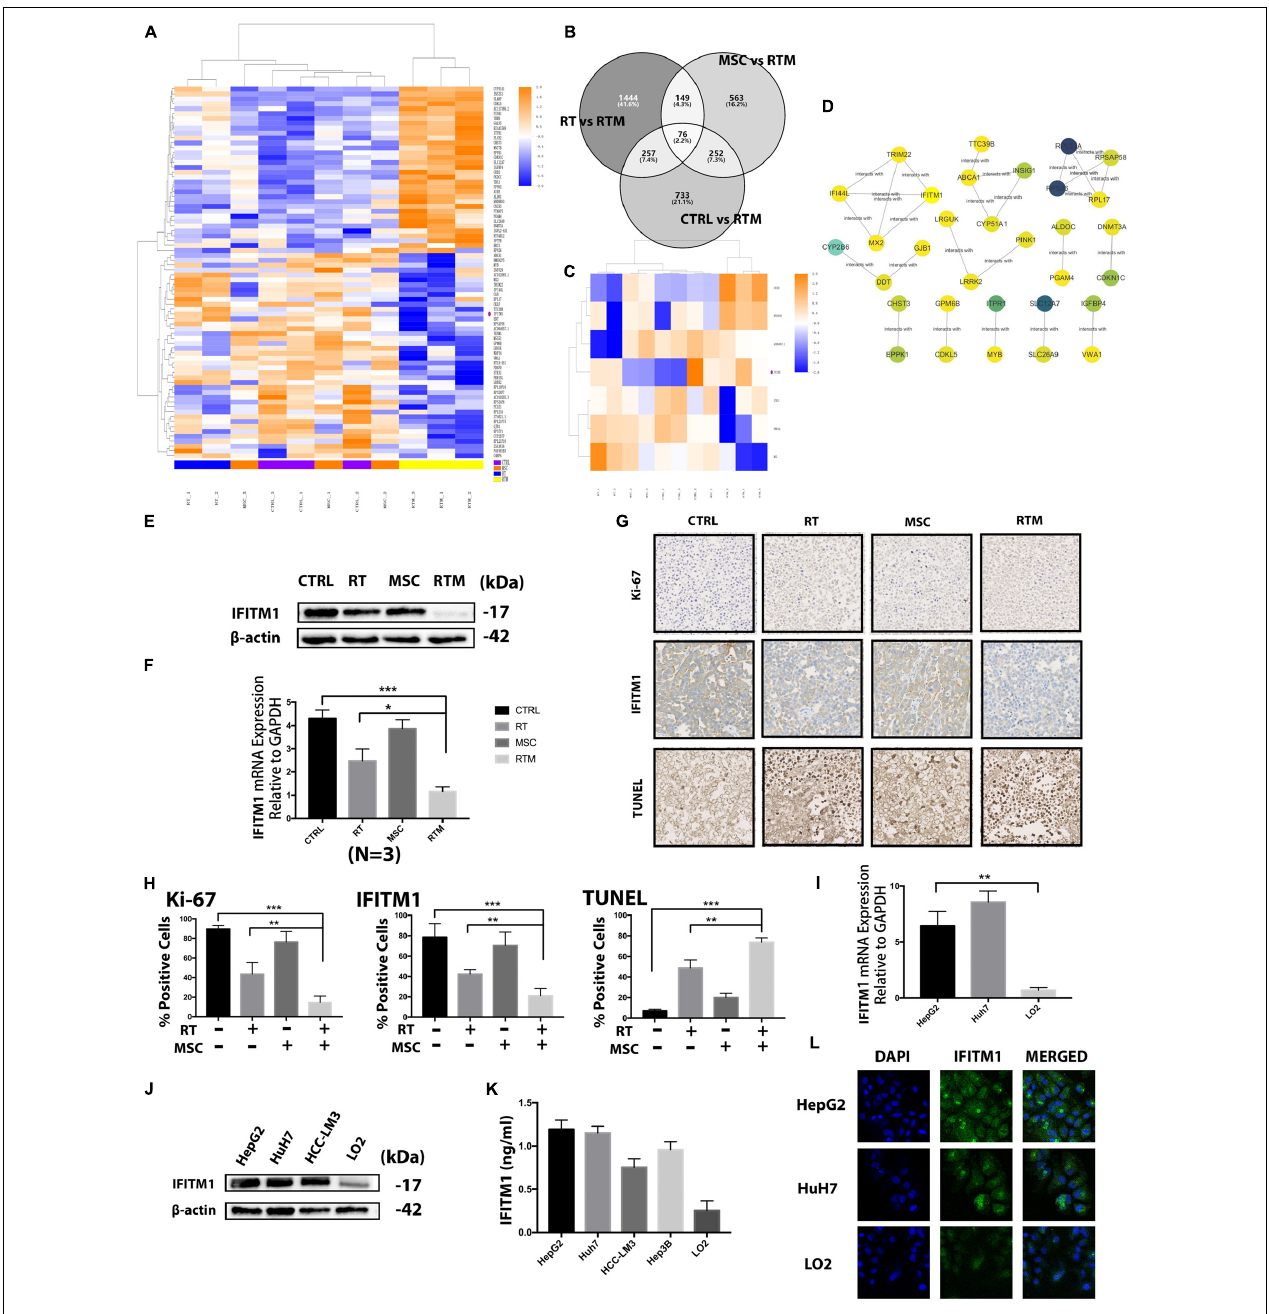
FIGURE 5 | Screening of the functional gene in the combination strategy against HCC. (A) Heatmap of the RNA sequencing results. Changes in the relative abundance of proteins and components from Huh7 tumor-bearing mice treated with RT with or without AT-MSCs ( n = 2–3 per group). (B–C) Venn diagram and heatmap showing 76 genes differentially expressed between the CTRL and RTM, RT and RTM, and MSC and RTM groups. (D) Functional interaction sub-network constructed using module genes. (E) Western blot analysis demonstrating IFITM1 expression in HCC xenograft tumor samples. β -Actin was used as a loading control. (F) Detection of IFITM1 mRNA expression in xenograft tumor samples by qRT-PCR after RT with or without AT-MSCs treatment. Fold change expression was calculated with normalization to GAPDH as the internal control gene. Each value represents the mean ± SD from three independent experiments ( ∗ P < 0.05, ∗∗∗ P < 0.001). (G) Representative images of IHC staining of the proliferative marker Ki-67 (top) and IFITM1 and TUNEL staining (bottom) in xenograft tumors ( n = 3–5 tumors per group, five images per tumor. Scale bar = 100 µ m). (H) The percentages of Ki- 67-, IFITM1-, and TUNEL-positive cells are summarized in the bar chart ( ∗∗ P < 0.01, ∗∗∗ P < 0.001). (I) Protein expression of IFITM1 in HCC cells and the immortalized liver cell lines LO2 was detected by Western blot analysis. β -actin was used as a loading control. (J) Detection of IFITM1 mRNA expression in HCC cell lines and LO2 by qRT-PCR. The results are expressed as the means ± SD of three independent experiments ( ∗∗ P < 0.01). (K) Detection of secreted IFITM1 level in HCC cell lines and immortalized liver cell lines. (L) Representative image of immunofluorescence staining of IFITM1 (green) in indicated cells; nuclei are stained with DAPI (blue).